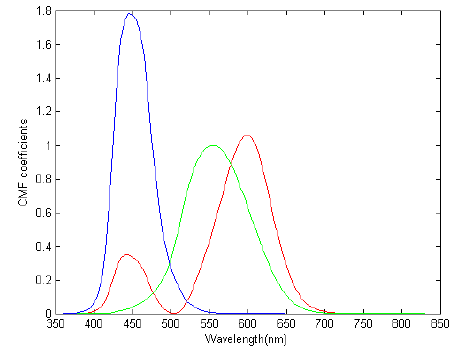
Figure 3. CIE 1931 color matching curve between 360 nm and 830 nm.